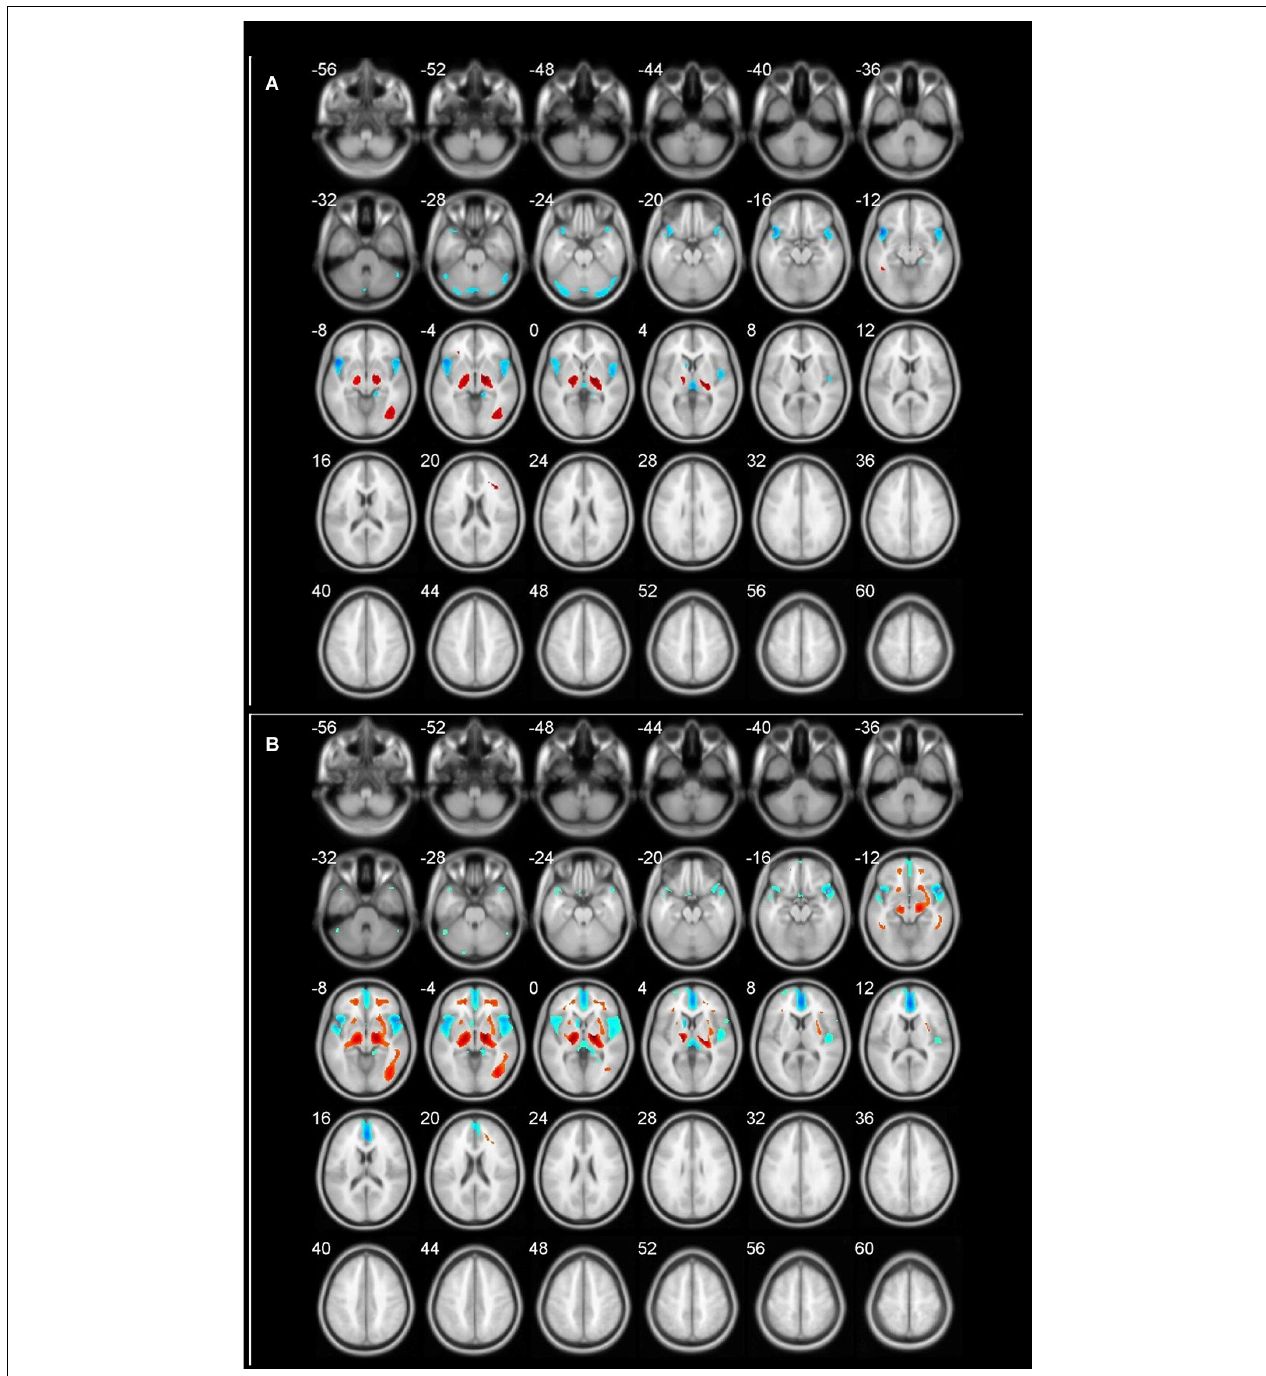
FIGURE 1 | Different brain regions in cohort (blue indicates decrease; red indicates increase). (A) 60–69 age group; (B) 70–89 age